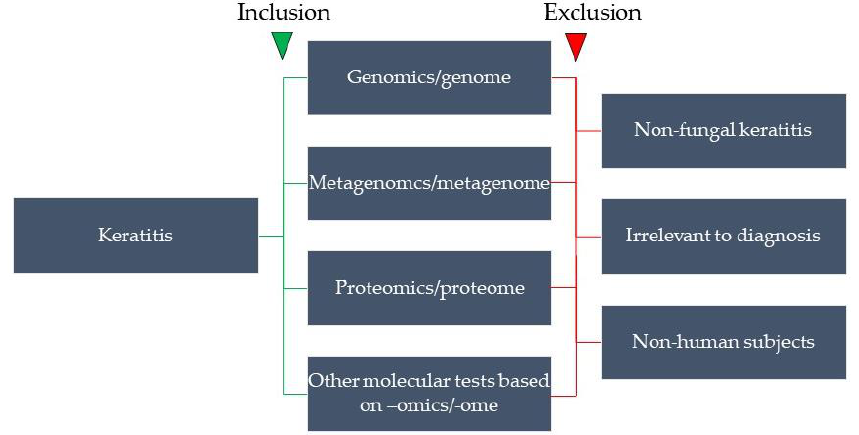
Figure 1. The inclusion and exclusion criteria of the PubMed search in this review.